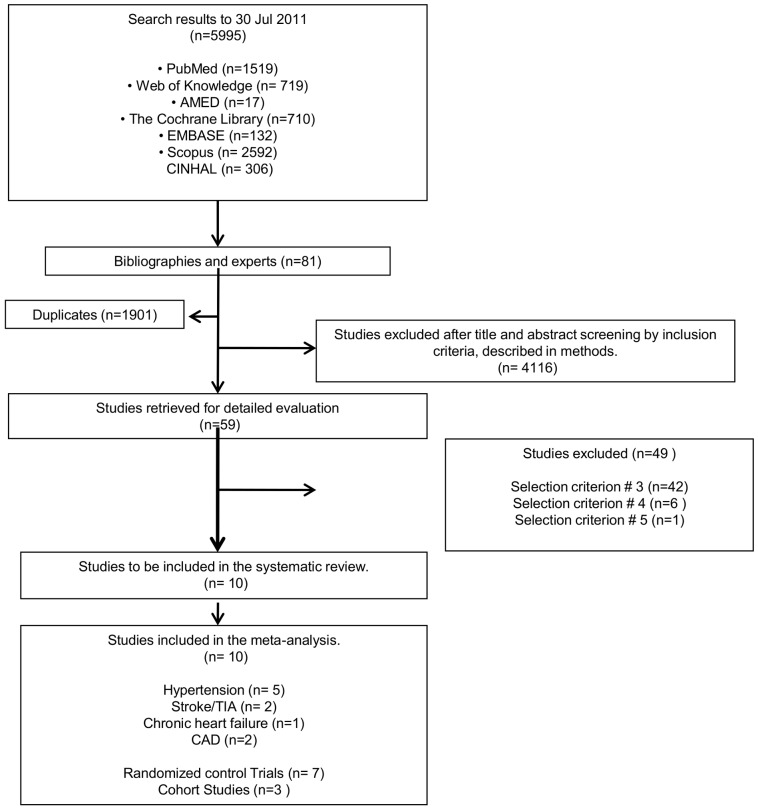
Flow diagram for the selection of studies evaluating the role of DSS in prevention of CVD.